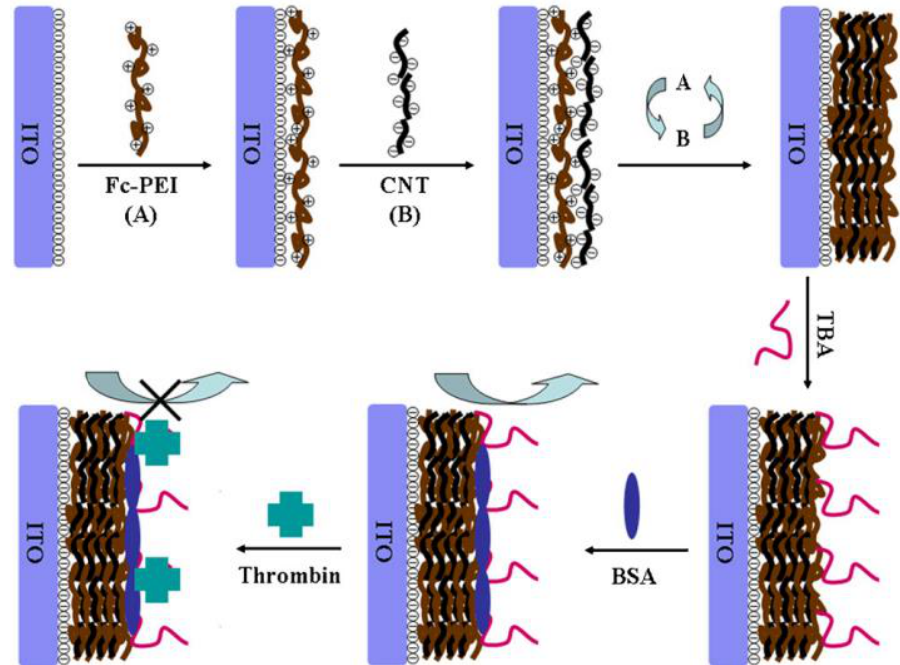
Figure 6. Schematic diagram of electrochemical aptasensing strategy based on the LbL method in the detection of thrombin. ( A ) immobilization of the ferrocene entrapped in PEI and ( B ) immobilization of carbon nanotubes. Reprinted from [71], with permission from the Elsevier.